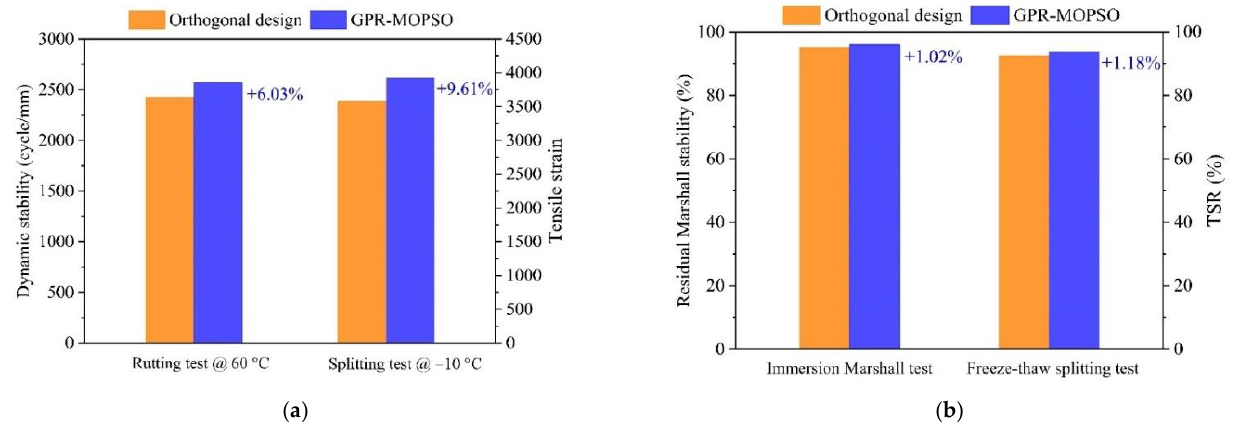
Figure 11. Performance verification between the orthogonal experimental design and GPR-AWMOPSO algorithm: ( a ) high- and low-temperature performances; and ( b ) moisture stability.